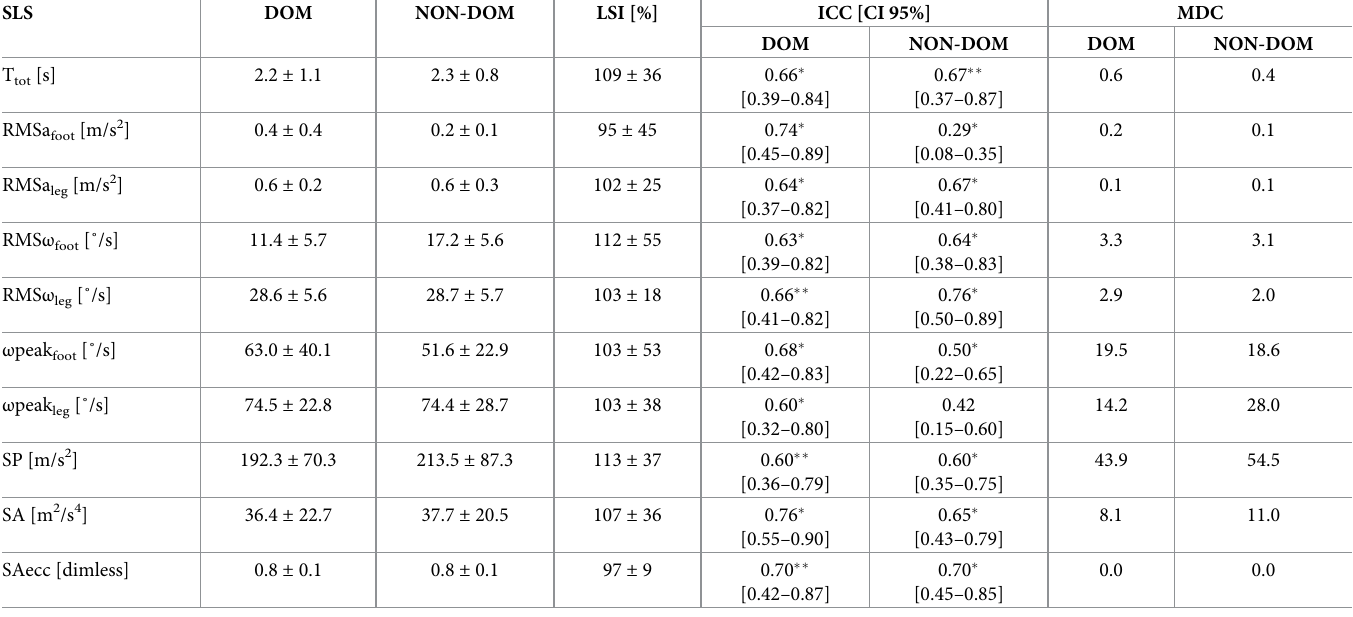
is considered, temporal- and angular velocity- related parameters, like the total test duration, Table 3. Results of the parameters estimated during the SLS (mean ± standard